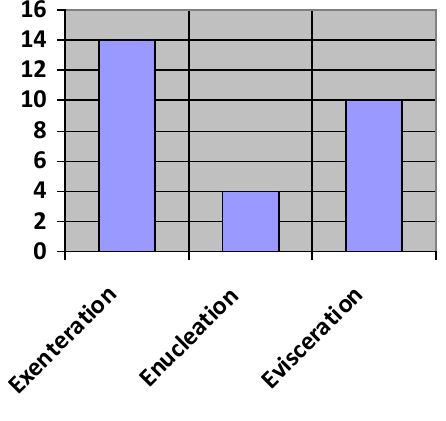
Figure 1. The distribution of surgical procedures performed on the study